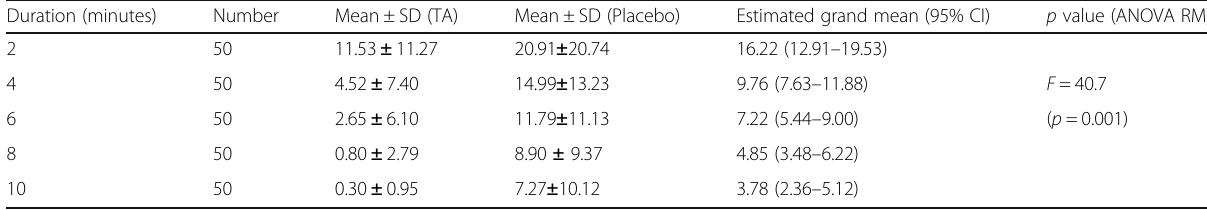
Table 1 Mean percent pain scores on visual analogue scale (VAS) with estimates ANOVA with repeated measures (RM) Duration